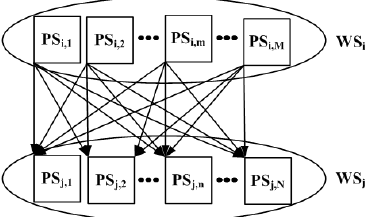
Fig. 4. Schematic Diagram of Physical